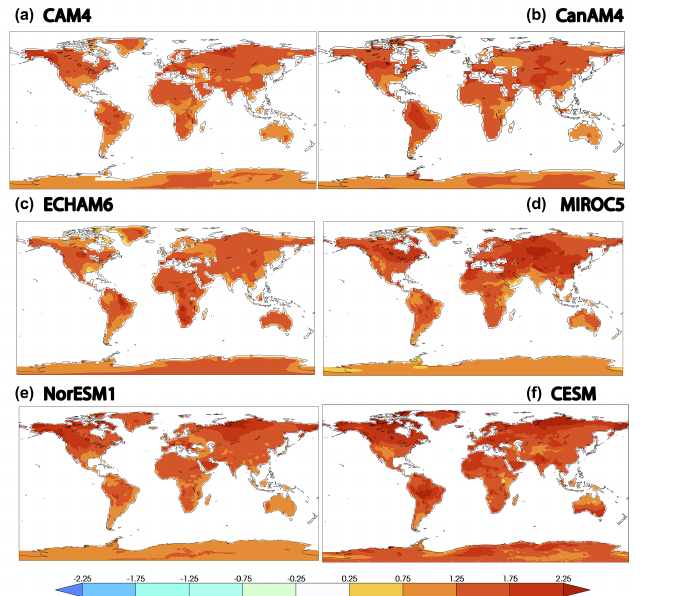
Figure A1. Differences in average hot season surface air temperature ( ◦ C) between the 2.0 ◦ C and present-day HAPPI simulations.